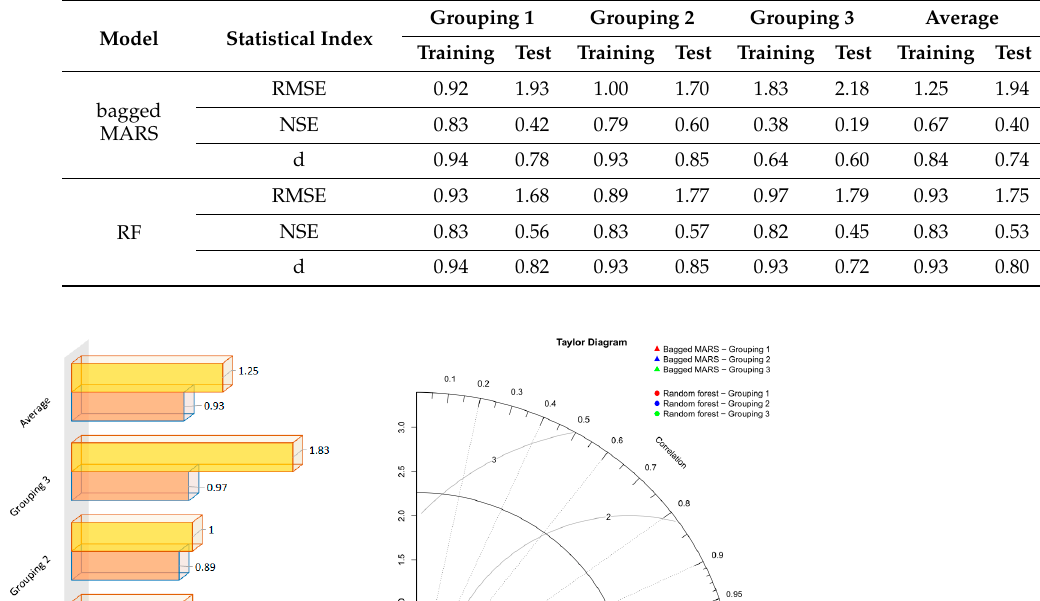
Table 2. Statistical metrics of bagging ensemble models (bagged multivariate adaptive regression splines (MARS) and random forest (RF)).